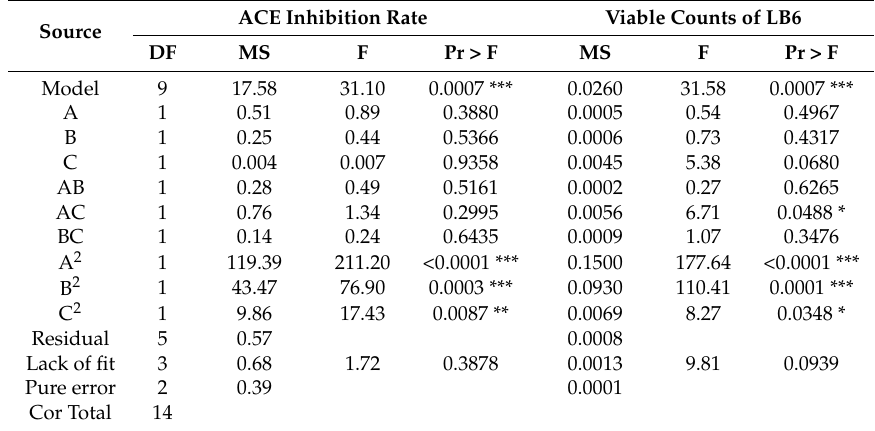
Table 3. ANOVA of response variables for ACE inhibition rate and viable counts of